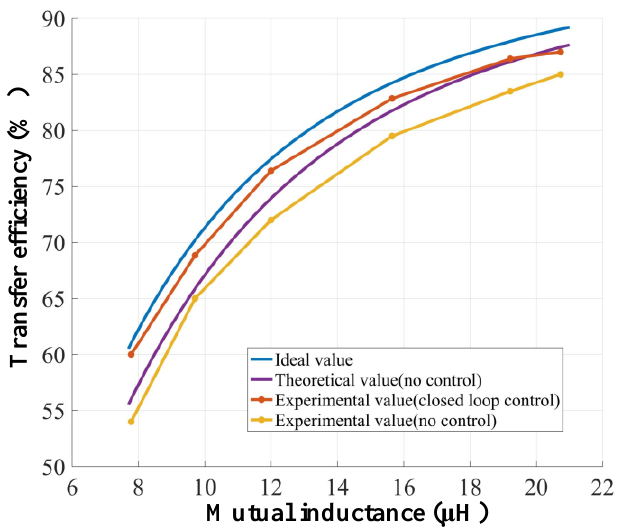
Figure 16. Transfer efficiencies under different conditions.